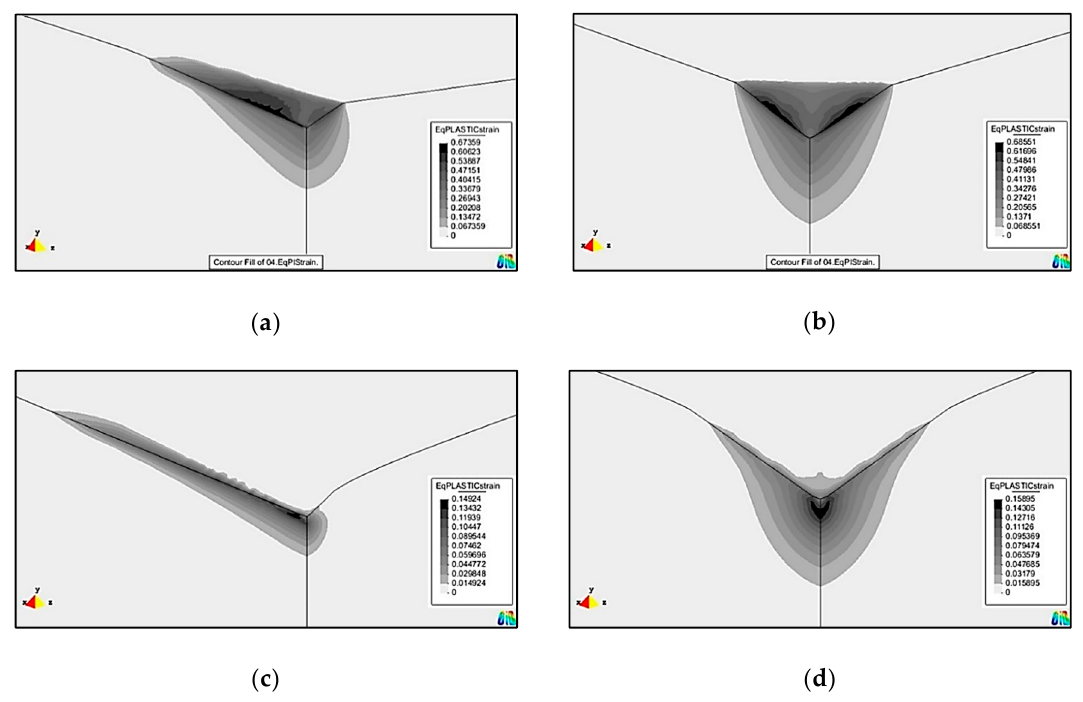
Figure 7. Equivalent plastic strain distributions obtained at maximum load in the numerical simulations using the Knoop and Vickers indenters: ( a , b ) Material M1; ( c , d ) Material M3.